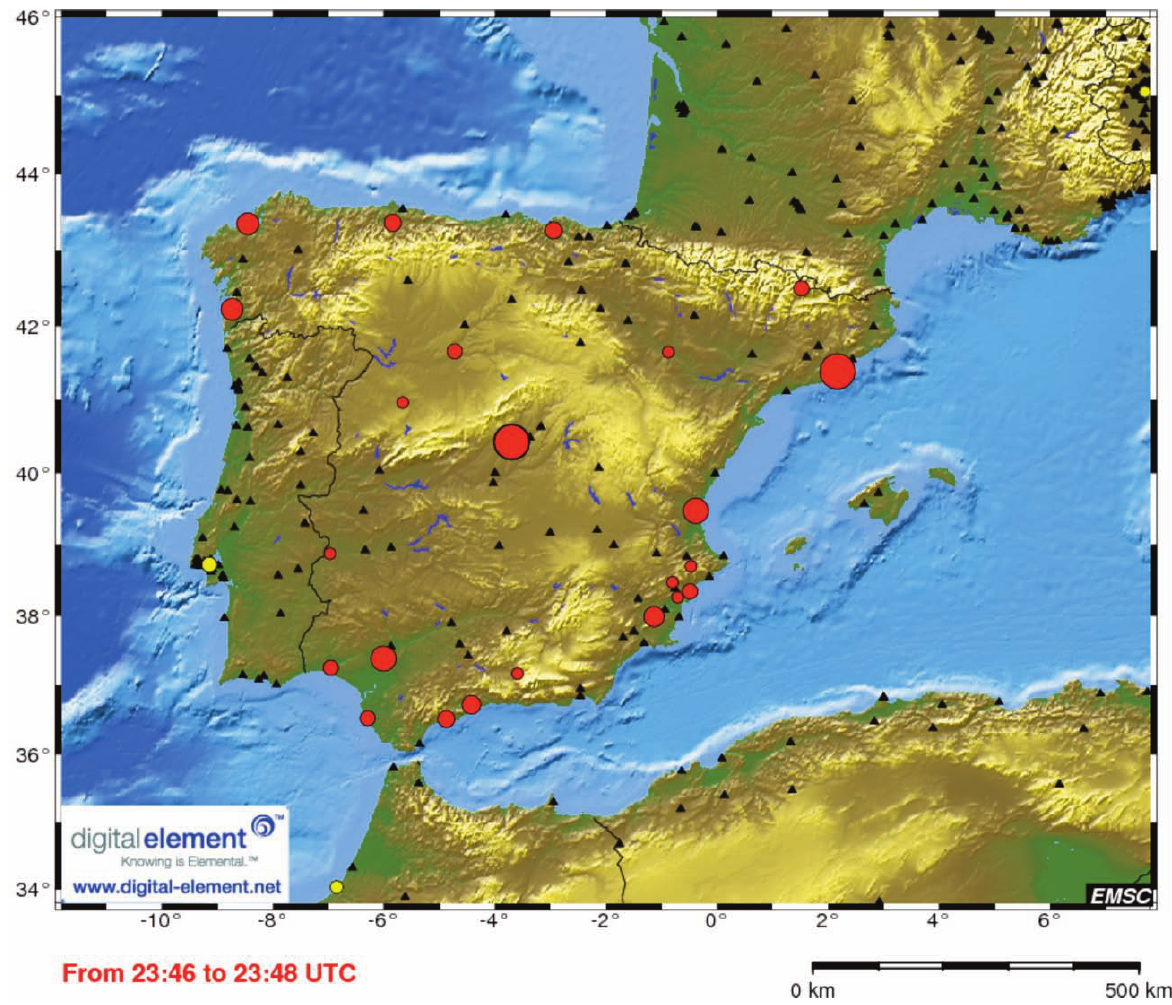
Figure 9. The television program in Spain that led to a website traffic surge (see Figure 4) generated a significant increase in the number of Spanish visitors of the EMSC website from all over Spain (see Figure 5a for